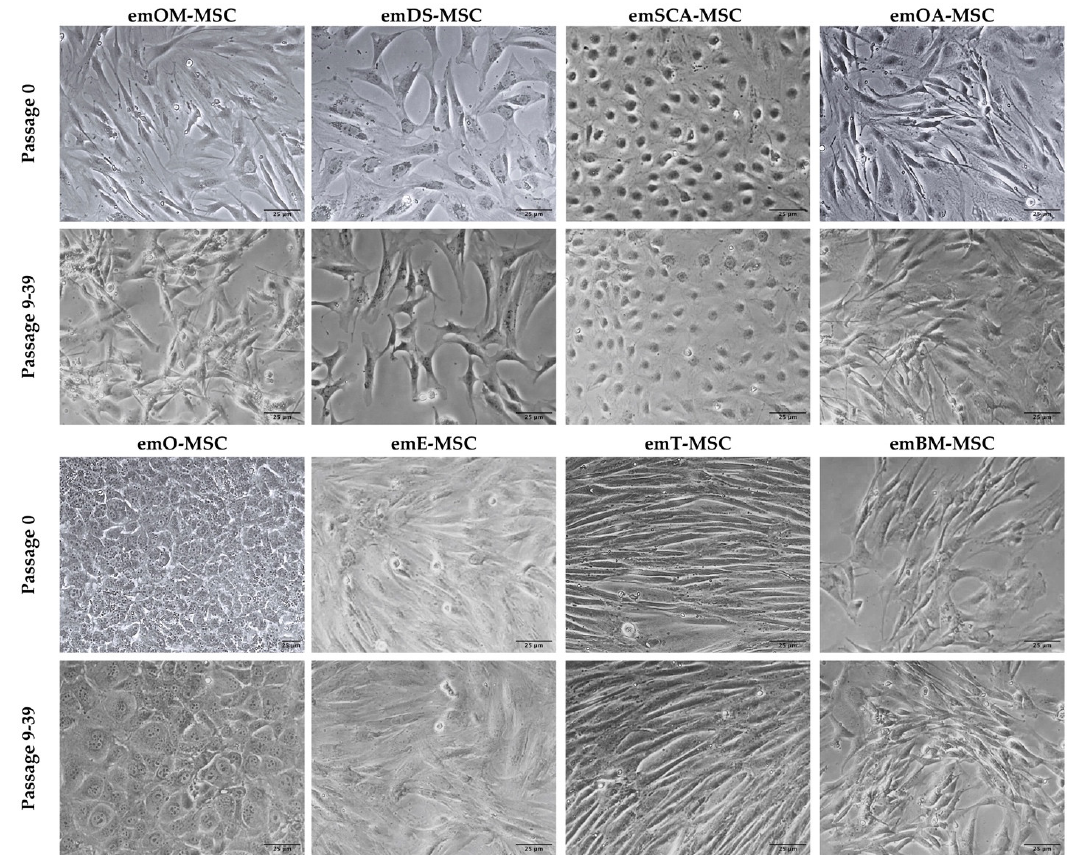
Figure 1. Phase-contrast images of different European mink MSC lines at Passage 0 (upper panels) and Passages 9-39 (lower panels). ×200 magnification. Bars = 25 μm.